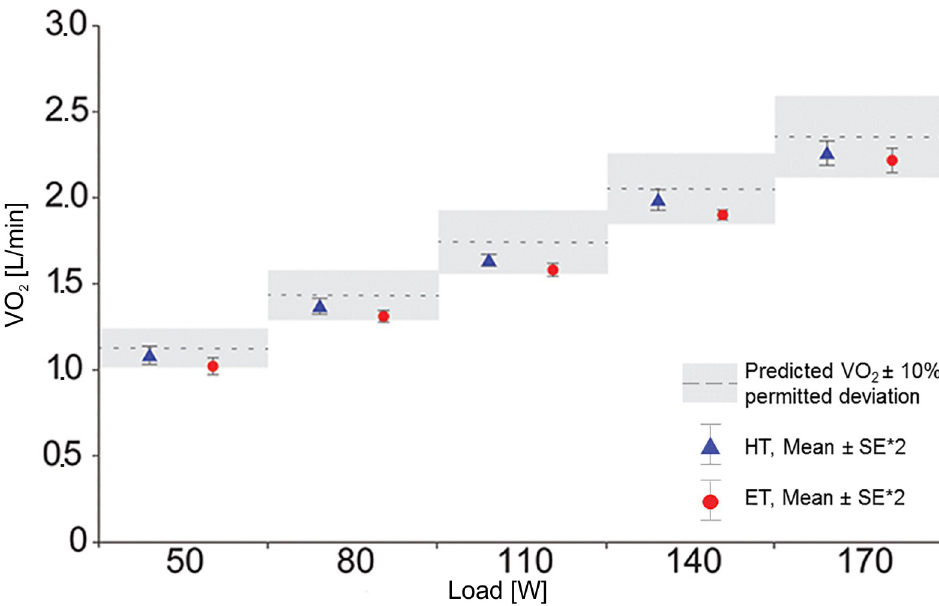
Fig 2. Comparison between HT and ET at FIO 2 = 20.78%. The dotted lines represent the _ VO man according to Wasserman et al. (2012). The grey block around the dotted line represent the permitted Deviation of ± 10% (see Table 2). The mean values of HT and ET at each load-level are shown with the double standard error to confidence of the plausibility of _ VO predicted. Abbreviations: HT Haldane Transformation, ET Eschenbacher 2 Transformation.